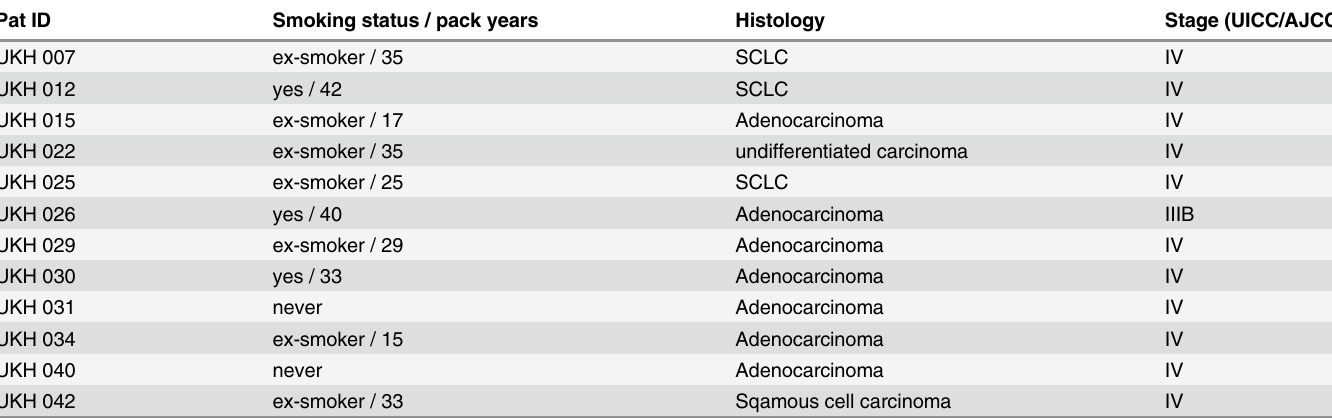
Table 2. Clinical data of fi rst-line patients responding to the therapy.